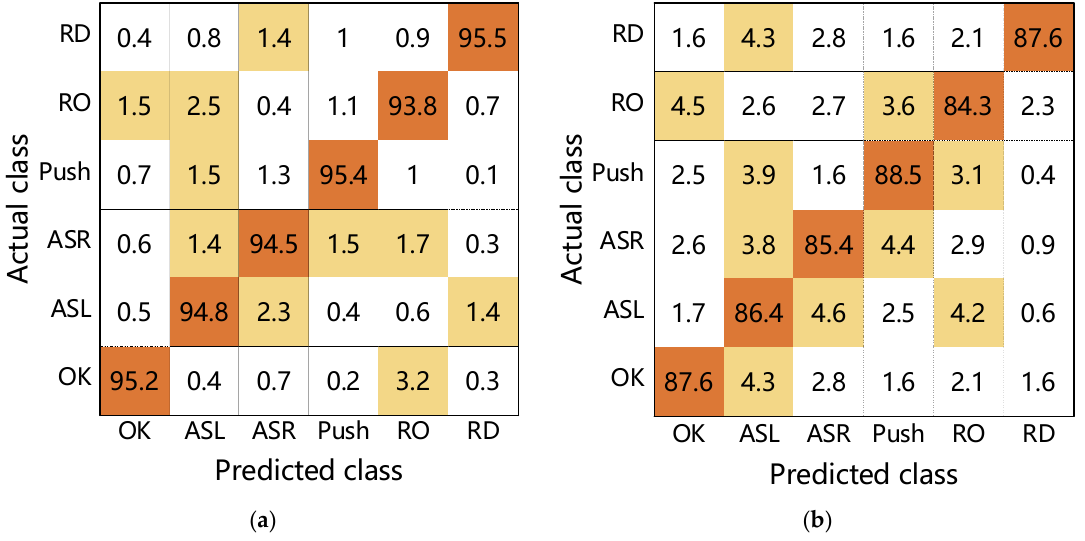
Figure 19. System generalisation capability test: ( a ) Testing in a conference room environment. ( b ) Testing in an office environment.